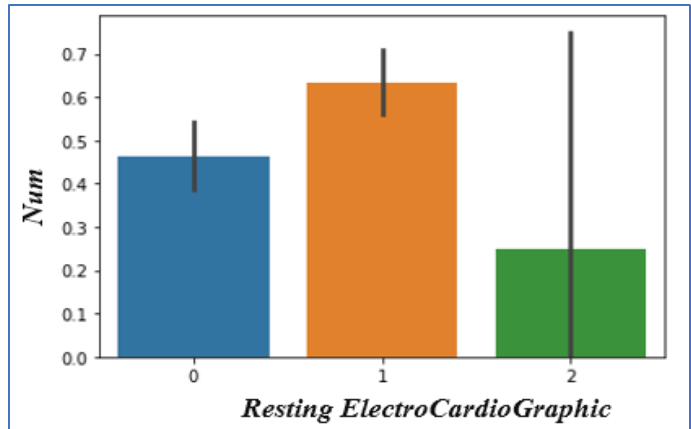
Figure 8. Resting ECG vs. heart disease chances.